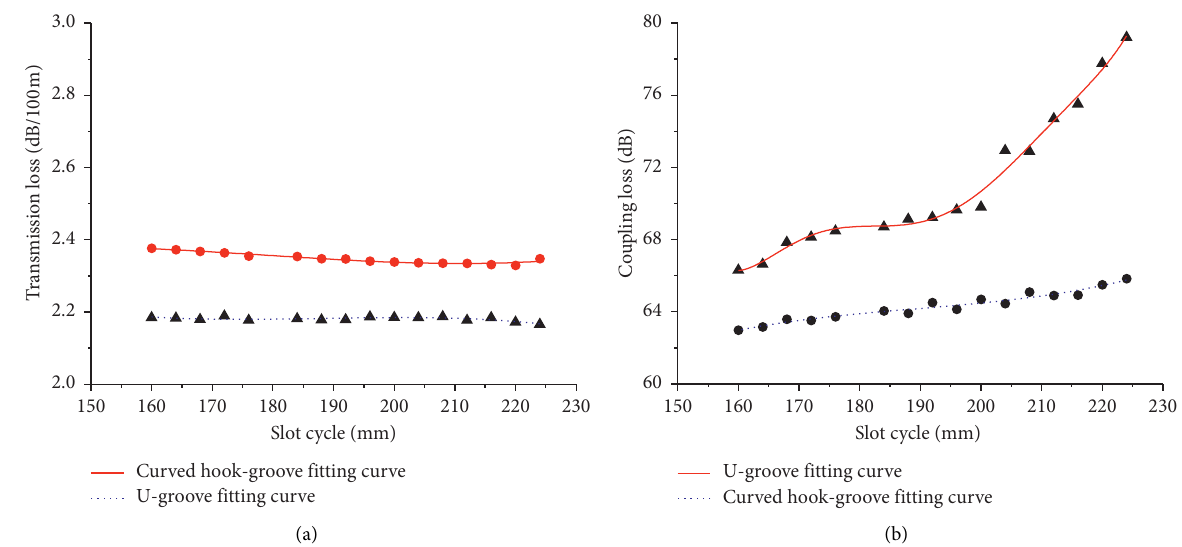
Figure 17: Trend of influence of groove width of U-groove and curved hook groove on the loss of leakage